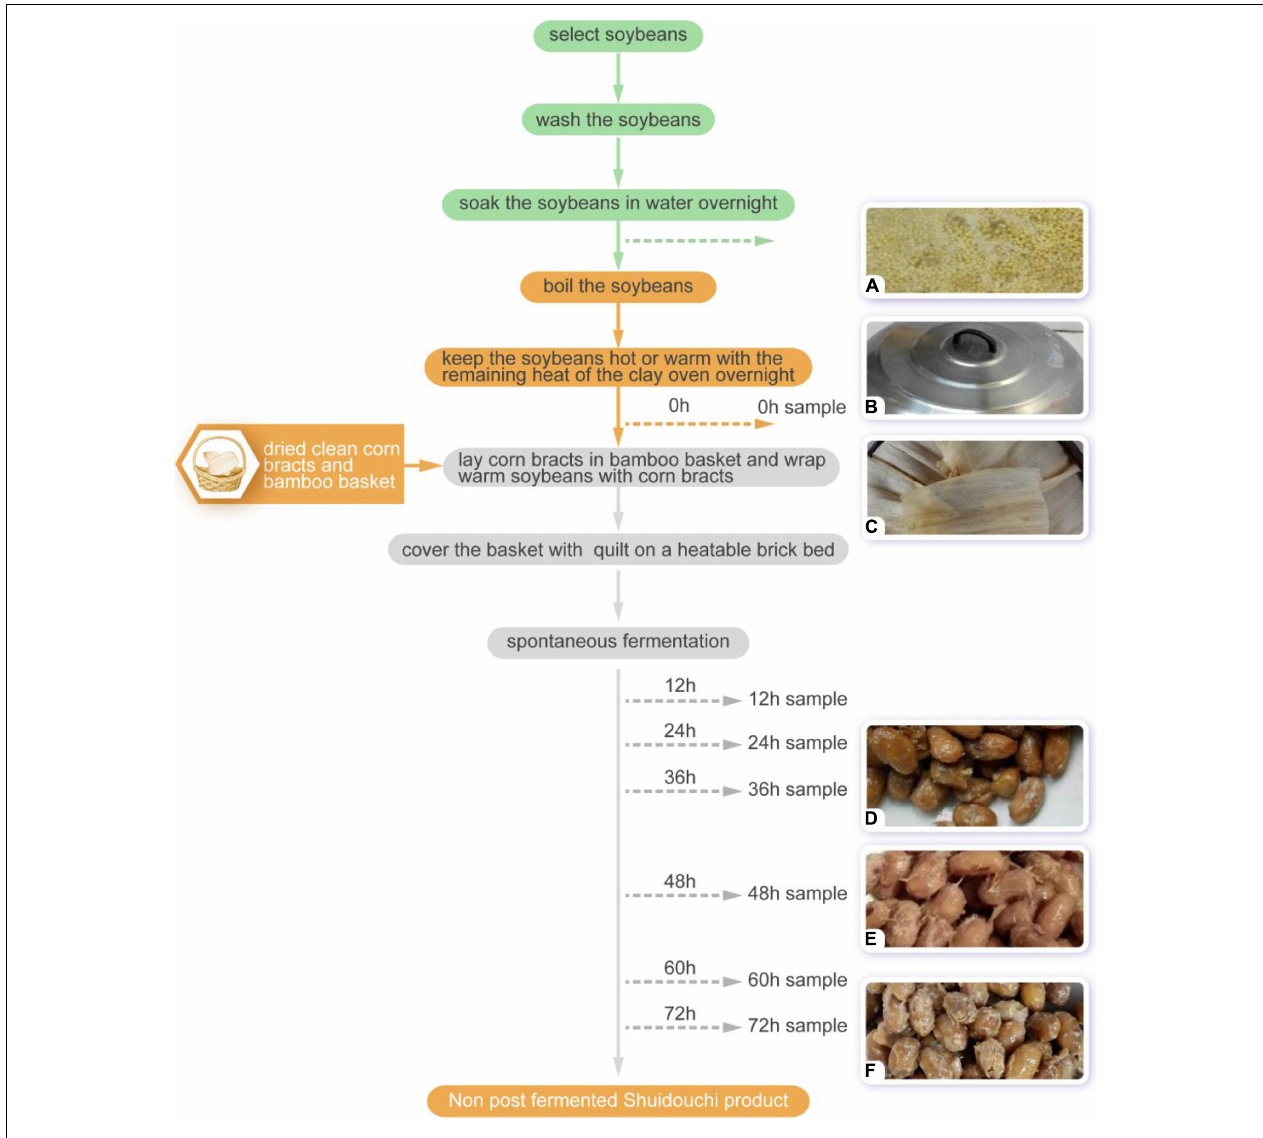
FIGURE 1 | The non-post fermented Shuidouchi process and sampling time points. (A) Boiled soybeans; (B) the soybeans were kept warm with the lid covered; (C) the soybeans were wrapped in corn husks; (D) mucus appeared at 36 h; (E) ropy appearance of the product 48 h; (F) 72-h